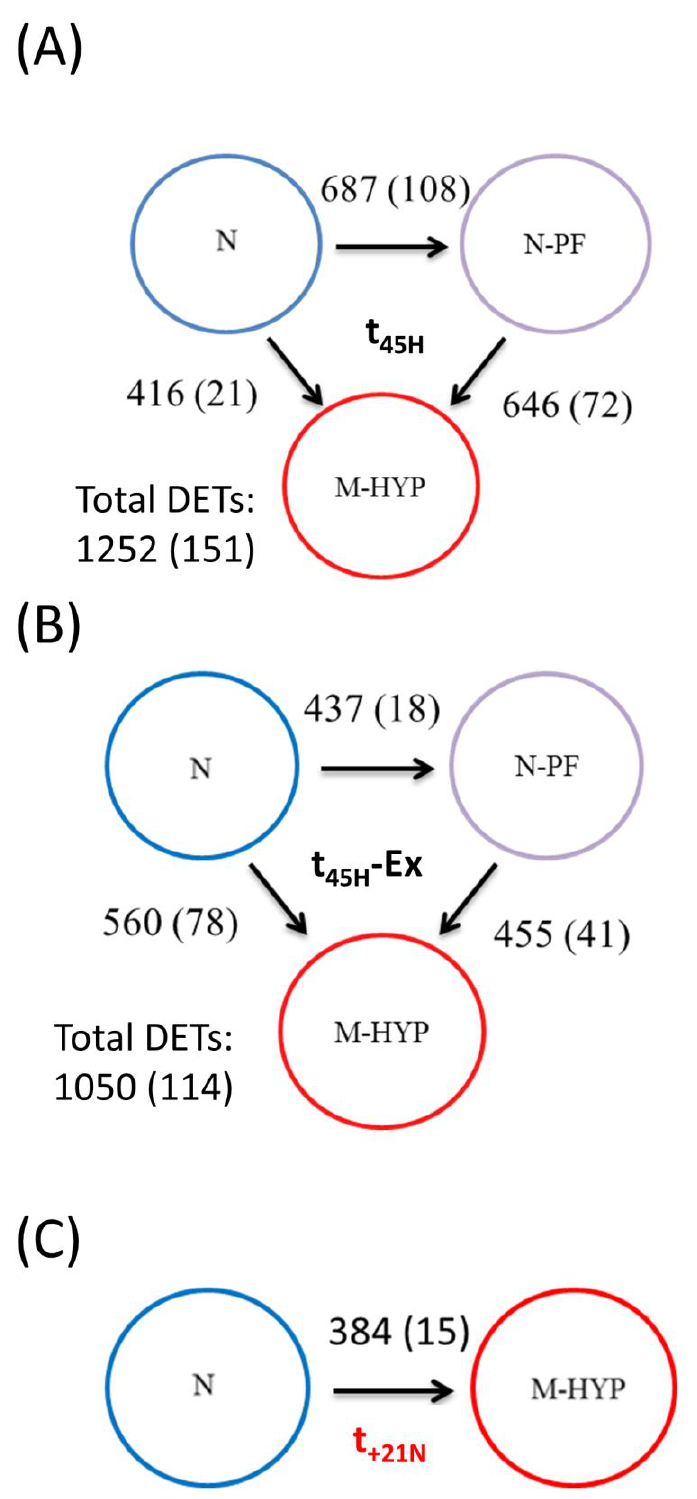
Figure 4. Differential expression analysis results at the end of the mild-hypoxia conditioning pe- riod (t 45H ) ( A ), after exhaustive exercise at t 45H ( B ), and after a 3-week normoxia recovery period (t +21N ) ( C ). Numbers over or next to the arrows indicate differentially expressed genes (ANOVA, p < 0.05) between groups. Numbers between parentheses indicate differentially expressed genes (FDR-adjusted p -value < 0.05) between groups.